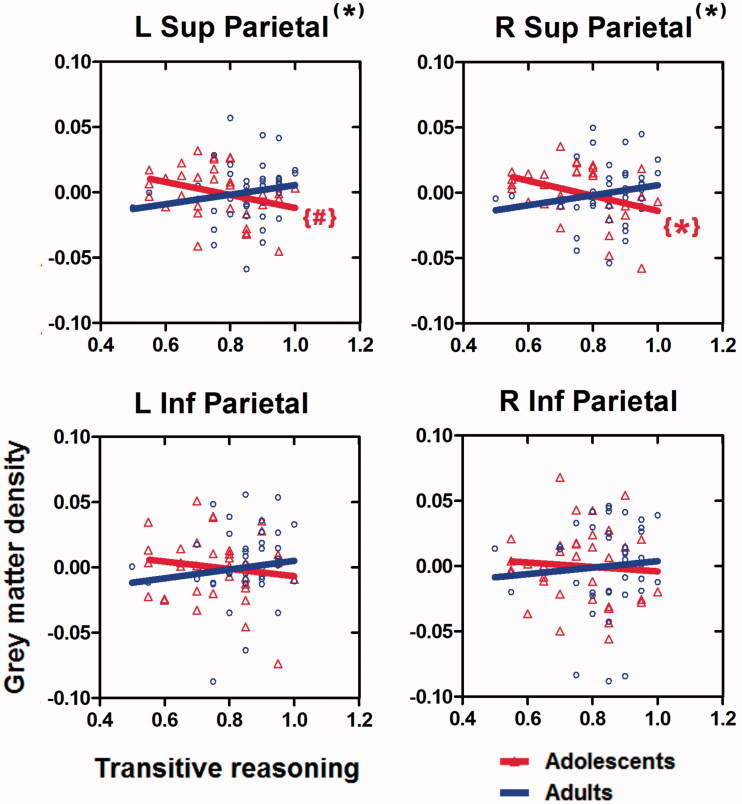
The region of interest analysis showed a significant interaction in the left and the right superior parietal regions (*), with significantly different regression slopes (of the regression lines between GM density and transitive reasoning accuracy) for the adults and the adolescents. There was no significant interaction in the inferior parietal regions. Red color is used to indicate the regression lines for young adolescents, whereas blue color is used to indicate the regression lines for adults. A significantly negative regression slope for the adolescents in the right superior parietal region was found {*}; the same contrast for the left superior parietal region was at a trend level {#}. Triangles (for adolescents) and circles (for the adults) show the adjusted grey matter density values. *p < .05, #p < .10; Bonferroni corrected for multiple comparisons.